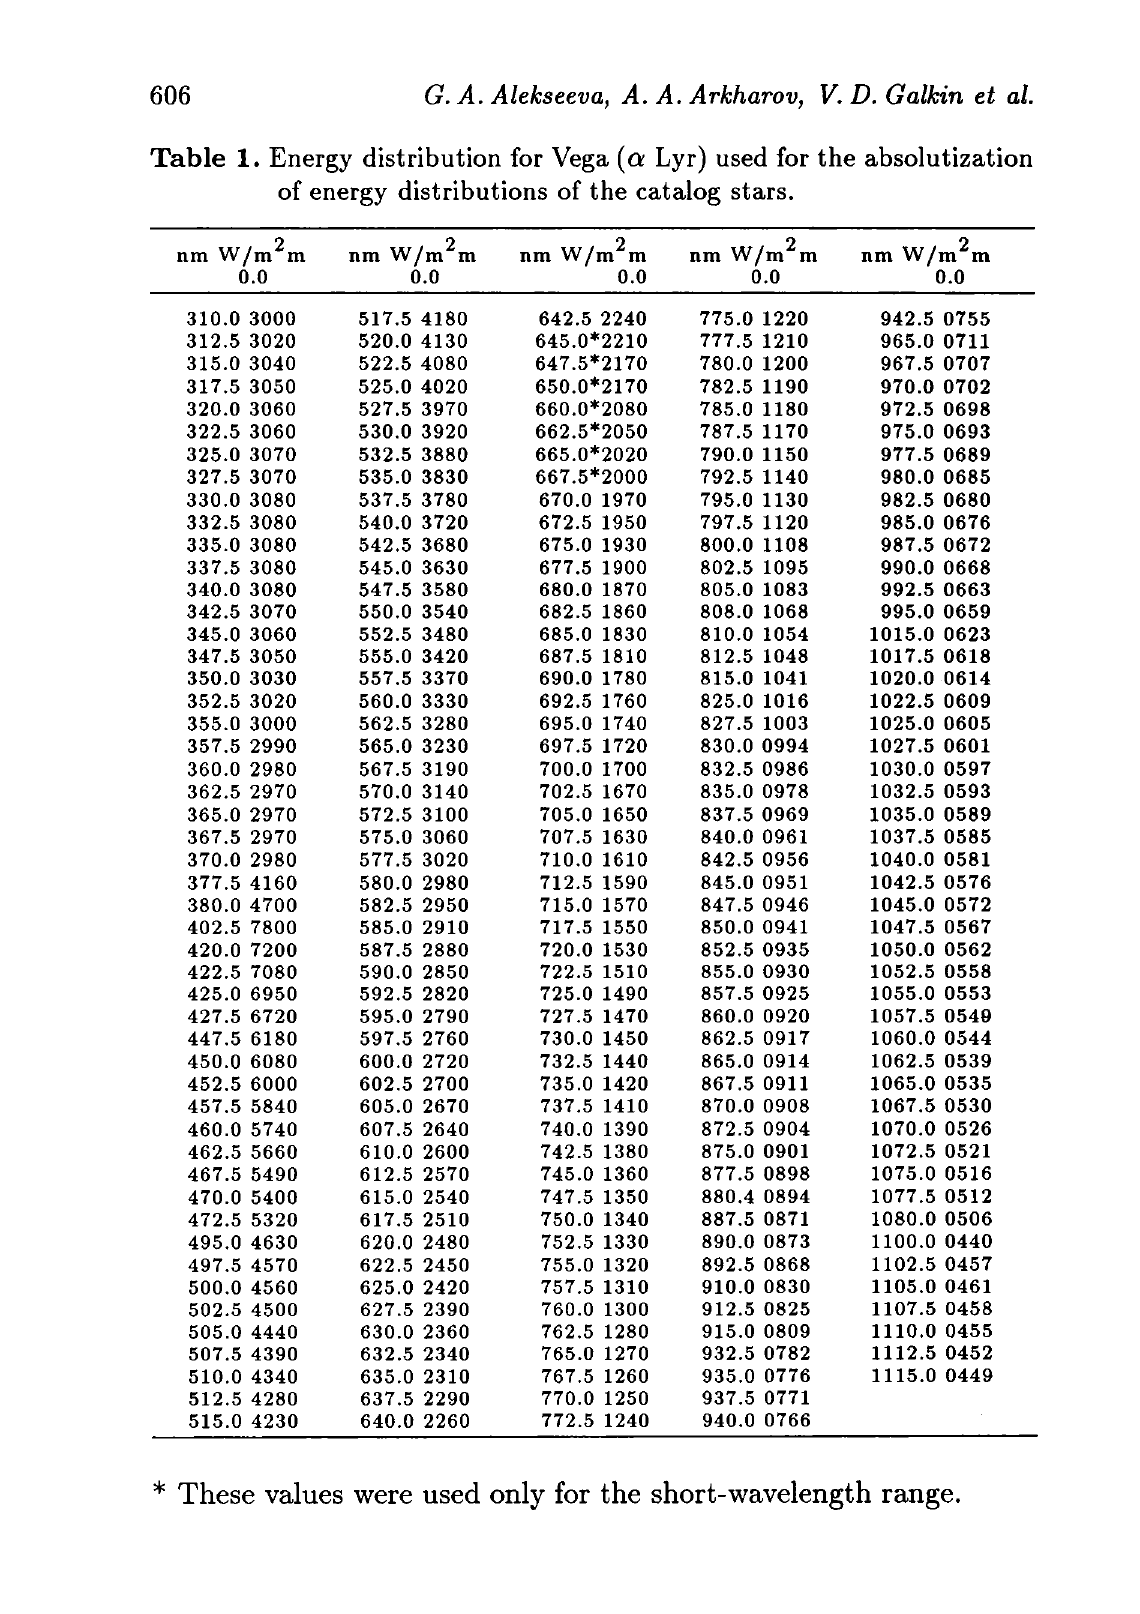
Table 1. Energy distribution for Vega (a Lyr) used for the absolutization of energy distributions of the catalog